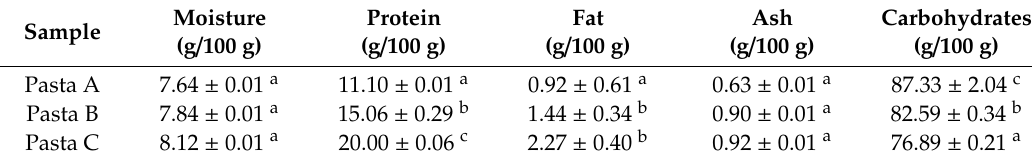
Table 2. Proximate analysis of the three types of pasta (dry basis).